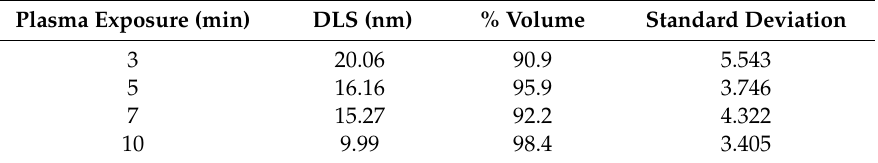
Table 1. Variation of DLS size values on di ff erent exposure times of cold Table 1 . Variation of DLS size values on different exposure times of cold plasma .